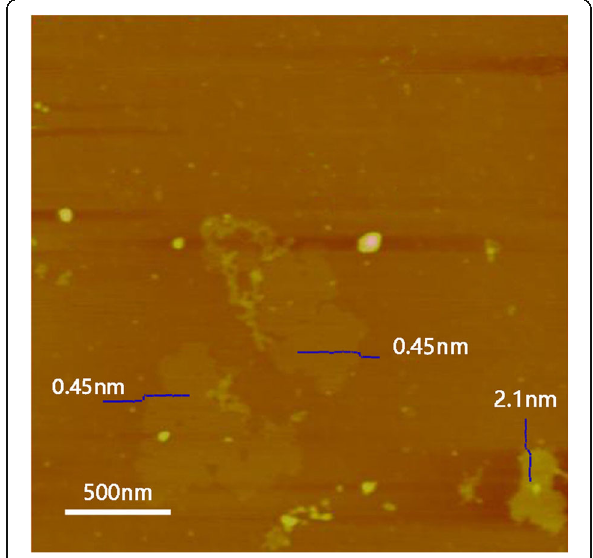
Fig. 4 AFM image of exfoliated TaS 2 nanosheets show the thickness of monolayer and three to four layers of TaS 2 sheets are about 0.45 and 2.1 nm,